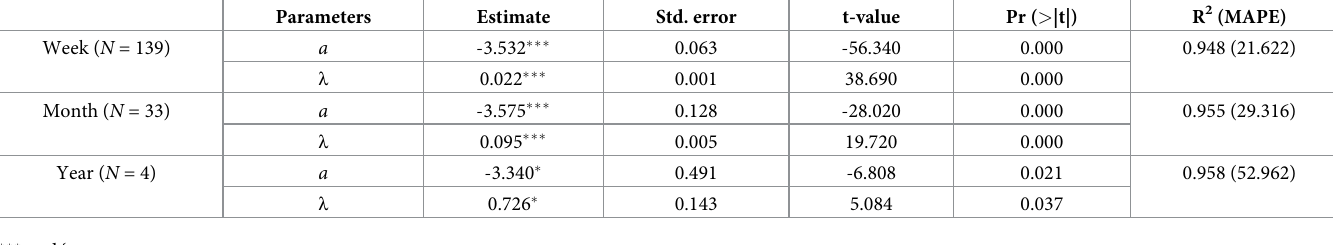
Table 2. Estimated logistic growth parameters.